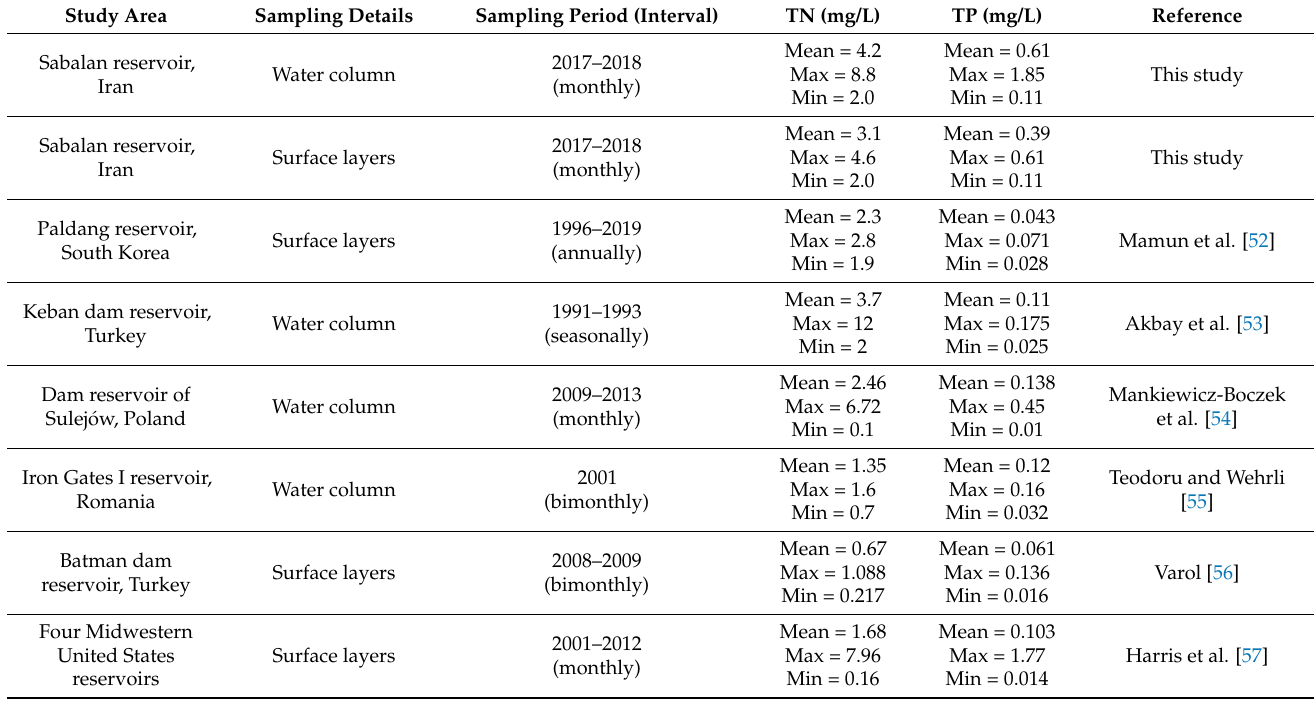
Table 1. Total nitrogen (TN) and total phosphorus (TP) concentration in some selective reservoirs around the world. Study